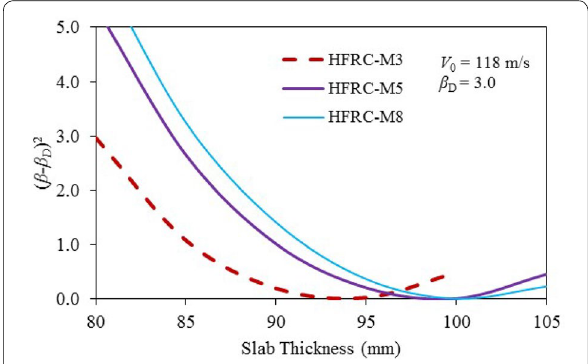
Fig. 9 Effect of slab thickness on reliability of HFRC slab